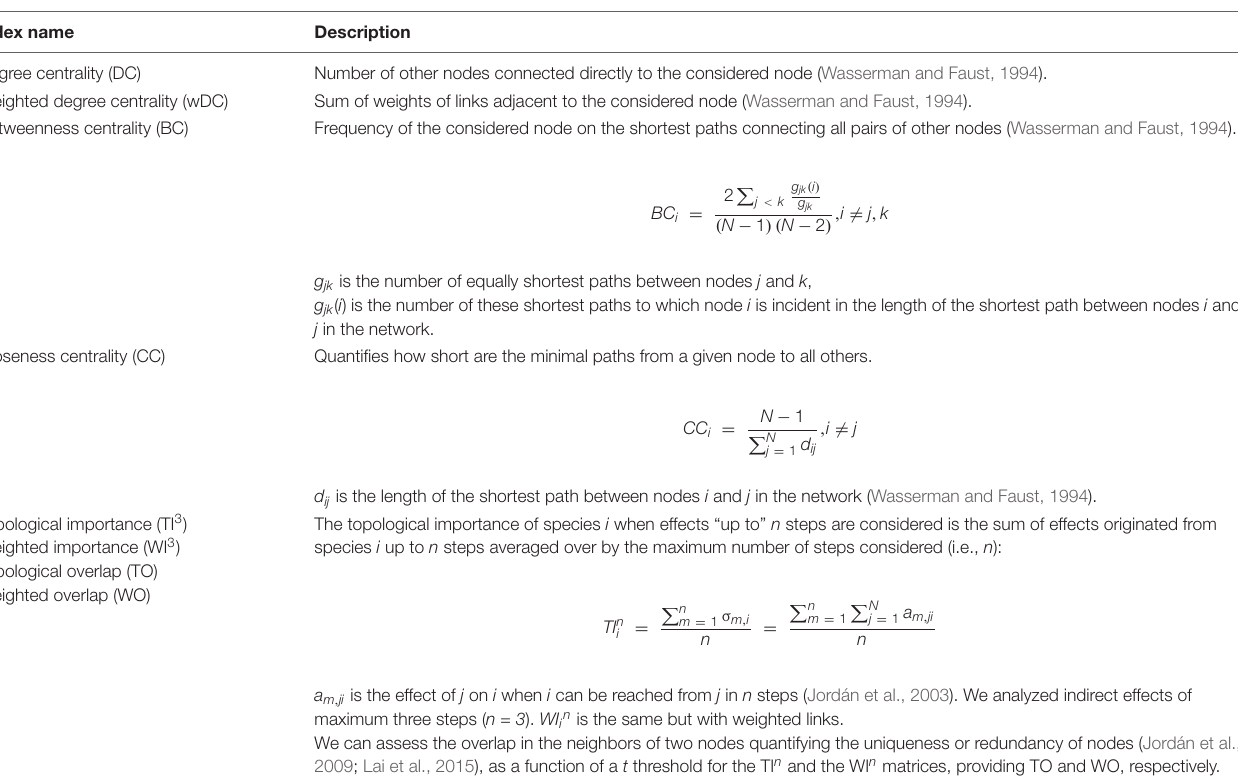
TABLE 1 | List of topological